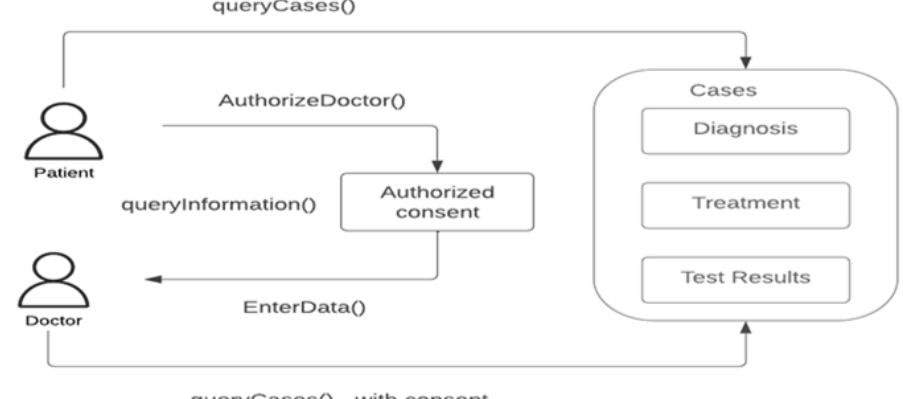
Figure 3. System workflow.